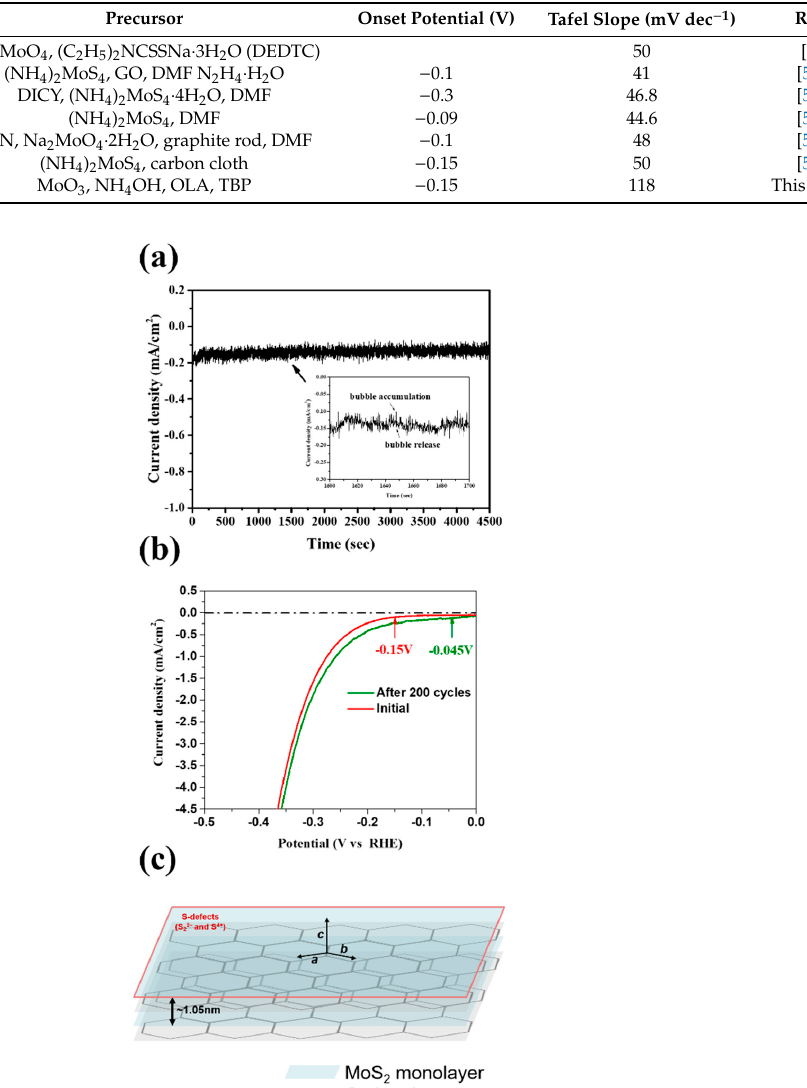
Table 1. Comparative analysis of the HER performance of MoS 2 / C electrocatalysts.